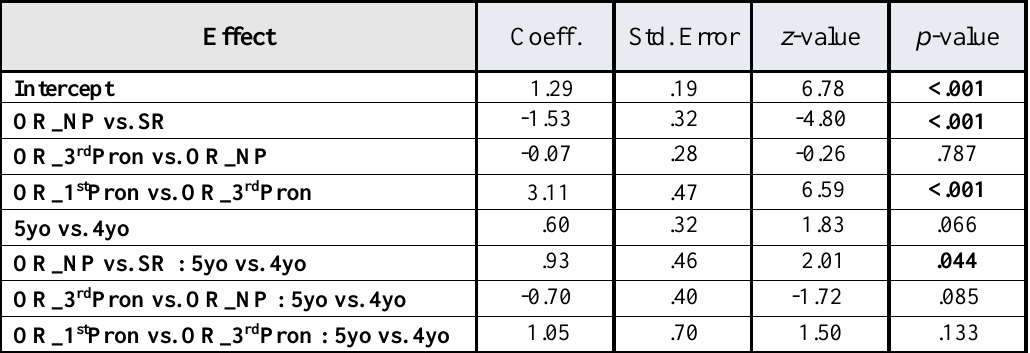
Table 1. Summary of the fixed effects of the generalised mixed-effects model. Significant effects are indicated in